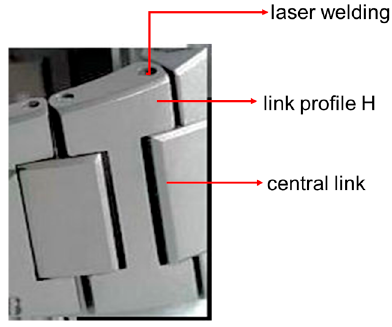
Figure 1. Strands of a watch strap.